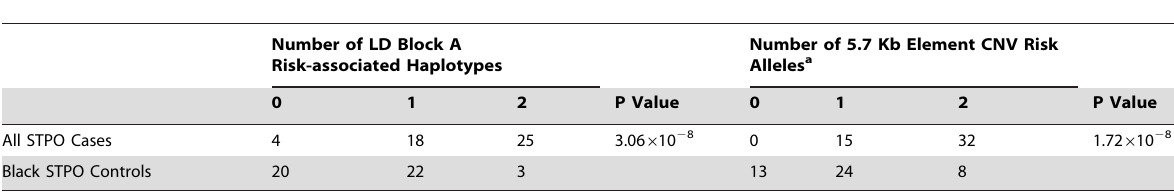
Table 3. Association between SCCD risk and the 5.7-Kb element CNV in the STPO cases and controls.